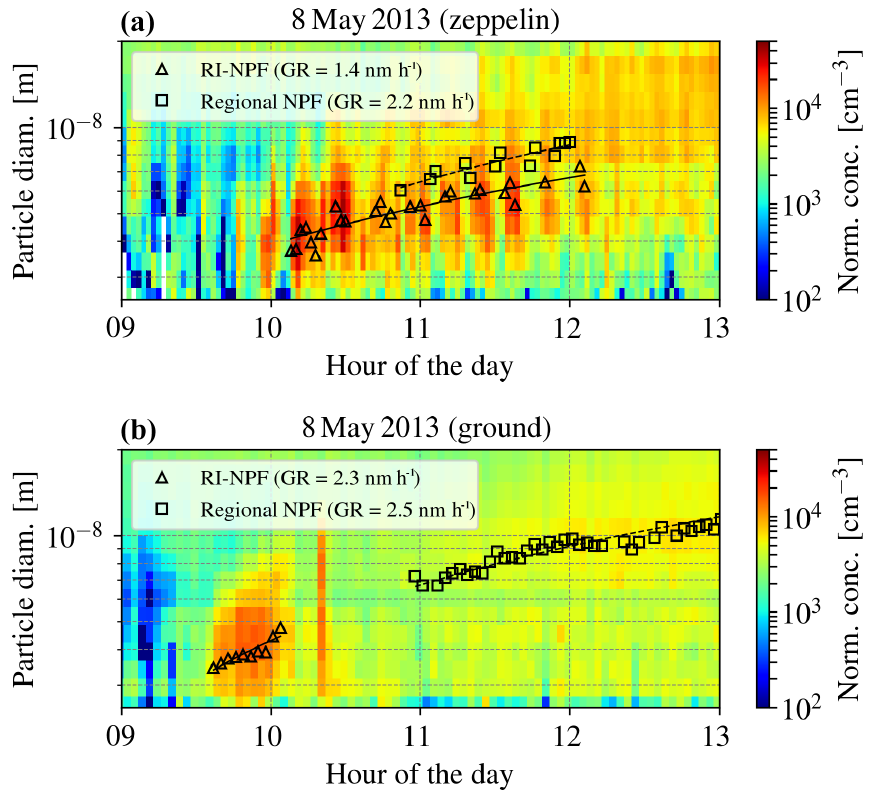
Figure 11. The particle number-size distribution (positive polarity) between 2.5 and 20nm measured by the NAIS (a) on board the Zeppelin and (b) at the field station on 8 May 2013. Between 10:00 and 12:00, the Zeppelin consecutively flew through the roll-induced NPF (RI-NPF) event leaving concentrated “stripes” on the particle number-size distribution. Between 09:30 and 10:00, the roll-induced NPF event moved over the field station. The black triangles and squares show the fitted mean mode diameters to the roll-induced and regional NPF event particles, respectively. Figure 8b shows the simultaneous observations from the airplane. The roll-induced NPF event was moving over the measurement area from southwest to northeast. Weather radar observations showed that rolls were present over the measurement site, and power spectra of the wind components from the station’s mast showed that the rolls were moving over the site at the same rate (one roll in ∼ 20min) and in the same direction as the roll-induced